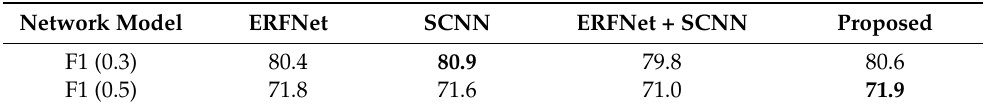
Table 4. Results of the comparison of our model with similar network models. The bold scores are the best.